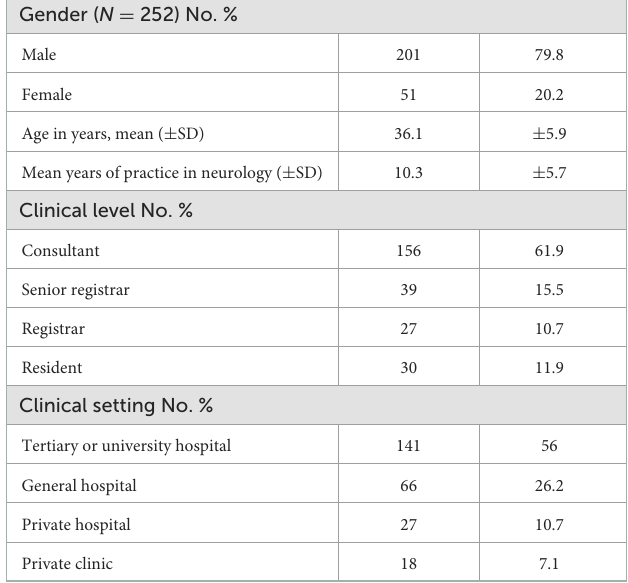
TABLE 1 Demographic characteristics of